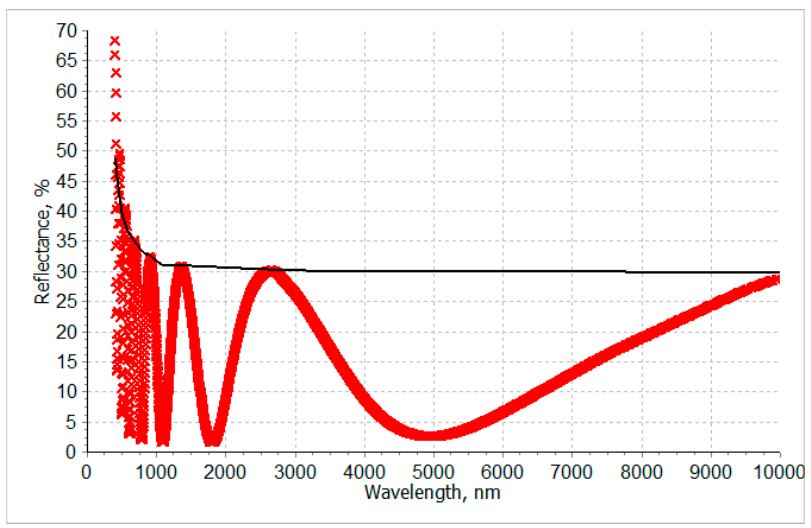
Figure 2. Transmission spectrum of a Al 2 O 3 monolayer with a thickness of 1 μ m deposited onto a substrate of Asahi optical glass.